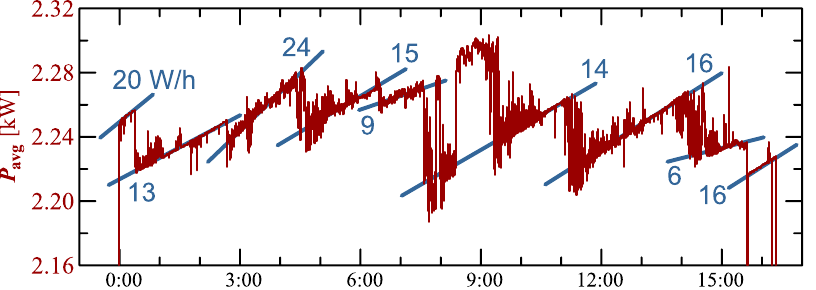
Figure 39. The characteristic of the average values of active power for Case V with information about the slope in graphical (trend lines) and numerical (value inW/h) form.